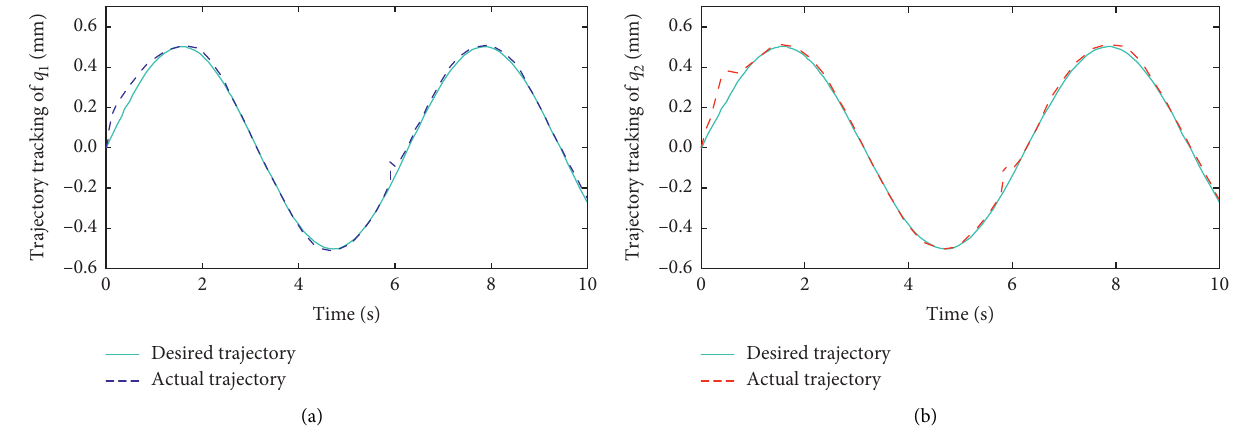
Figure 10: Trajectory tracking of the two-link robotic manipulator under external disturbances.